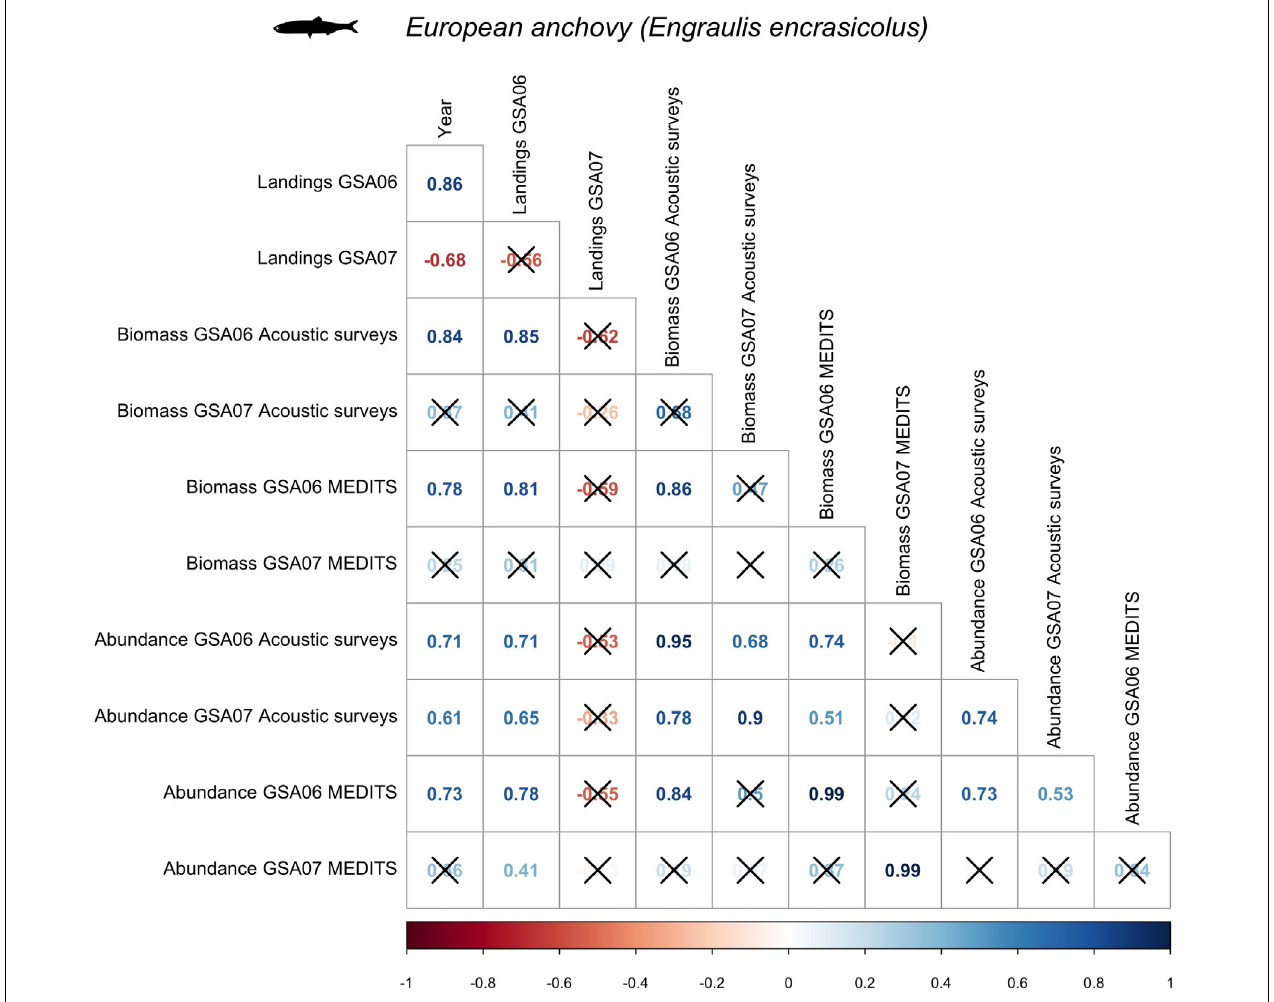
FIGURE 5 | Spearman’s correlation for European anchovy ( Engraulis encrasicolus ) among biomass and abundance collected during acoustic (ECOMED, PELMED, and MEDIAS) and demersal (MEDITS) surveys, as well as official countries landings, in the Geographical Sub-Area 06 and 07 from 2003 to 2016.